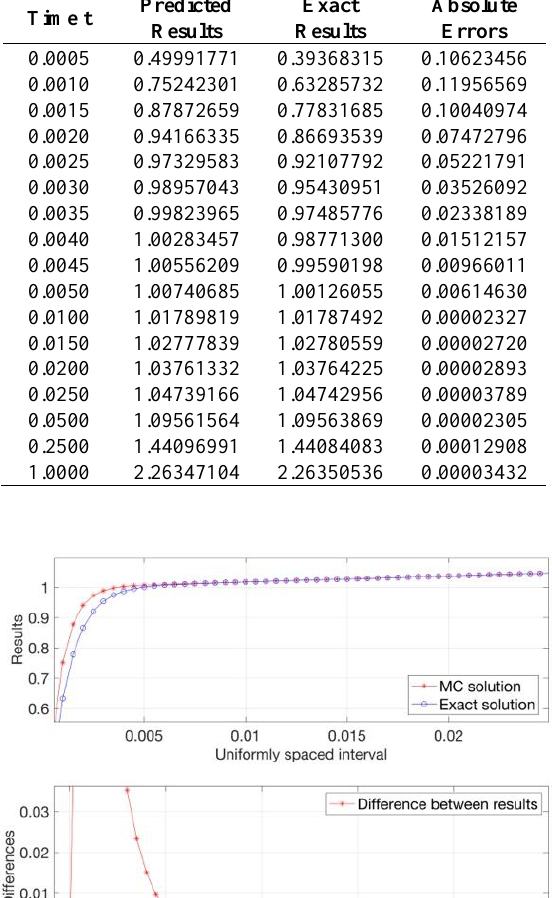
Table 1. Numerical results of Equation (3)